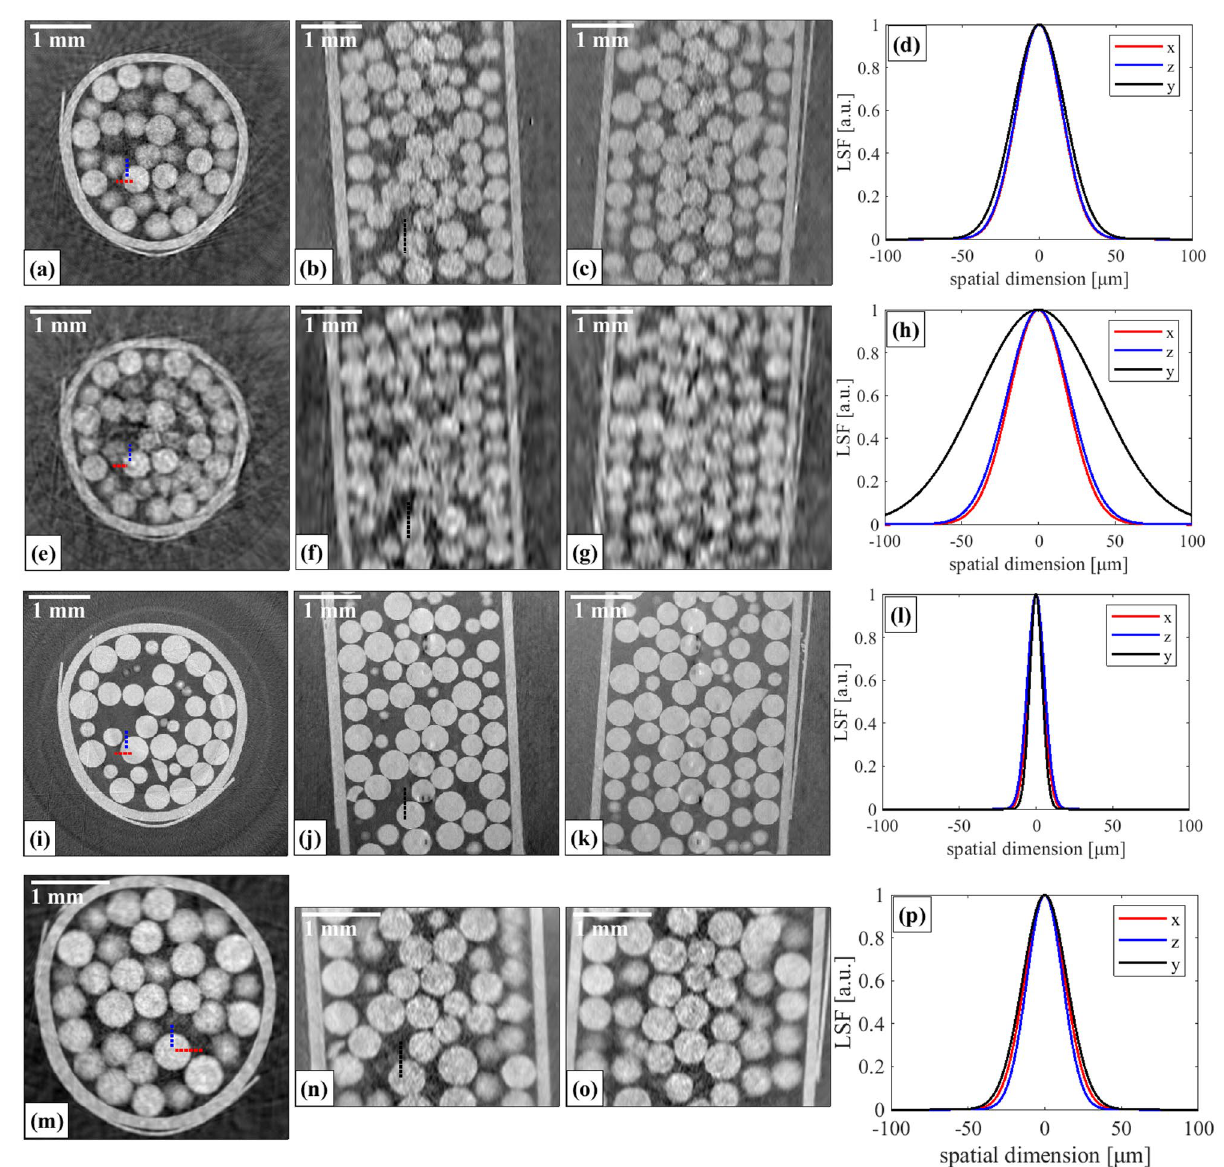
Figure 3. Reconstructed axial (left), sagittal (central left), and coronal (central right) planes of the sphere phantom, and the corresponding line spread functions (right) extracted from the sphere edges indicated with corresponding colours along the x , y and z axes. Results are shown for a cycloidal-spiral sub-sampling with dx = dy = 20 μm ( a – d ); a rotation-only sub-sampling, i.e., dx = dy = 0 μm ( e – h ); the fully sampled (dithered) case (scan duration of 7.5 h) ( i – l ); a cycloidal-spiral flyscan performed with dx = dy = 20 μm (scan duration of 200 s) ( m – p